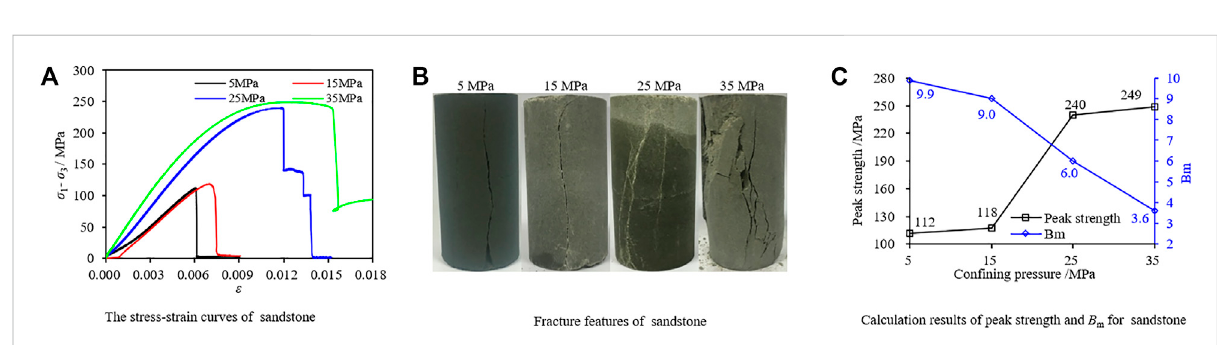
FIGURE 3 Test results and Bm values sandstone under different con fi ning